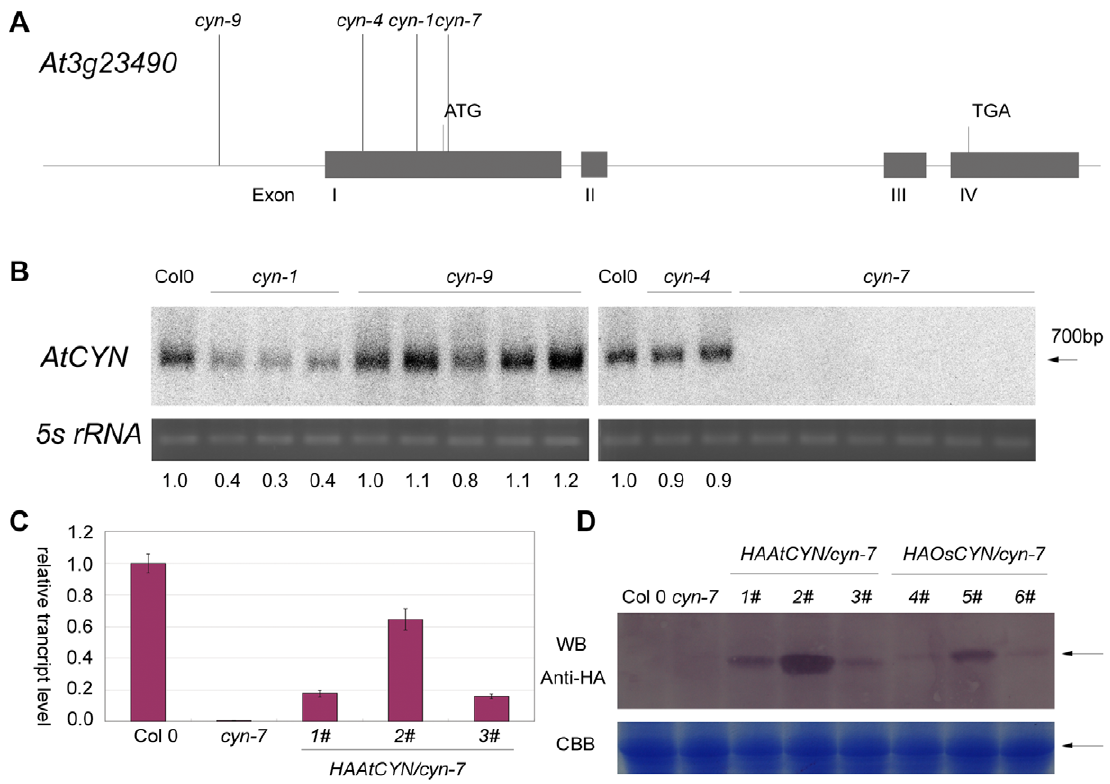
Figure 4. Identification of Atcyn mutant plants and transgenic plants. (A) Schematic diagram of the AtCYN gene and the T-DNA insertion positions. Gray boxes represent exons. Lines above the gene indicate T-DNA insertion positions. Accession numbers of the Atcyn mutant lines was listed in Table 4. (B) Northern blot analysis of AtCYN transcripts in cyn mutants. Total RNA was isolated from 14-day-old seedlings. Different homozygous individuals identified were analyzed in different lanes. Blot signals (indicated by the arrow) were quantified with ImageJ version 1.4 software and the values are presented below each lane. The 5S rRNA was visualized with ultraviolet light and was the loading control. (C) Quantitative RT-PCR analysis of AtCYN transcripts in Col 0, cyn7 and transgenic plants. Error bars represent the standard deviation of three biological replicates. (D) Semi-quantitative analysis of HA:AtCYN and HA:OsCYN in transgenic plants using western blotting (WB). Blot signals (indicated by the arrow) were quantified with ImageJ and the values are presented below the lanes. The large subunit of Rubisco was visualised by Coomassie Brilliant Blue (CBB) and was the total protein loading control (indicated by the arrow). doi:10.1371/journal.pone.0018300.g004 PLoS ONE |